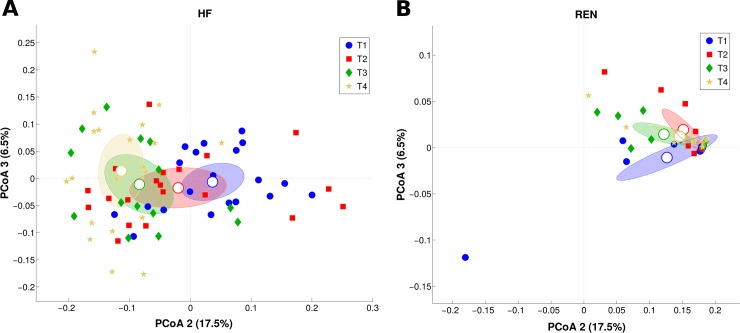
PCoA of weighted UniFrac distances representing the differences in milk microbiota structure along time points.Each dot represents a single quarter milk sample, while the centroid represents its average value. Percent variance accounted for by the second and third principal component is shown along the axis. (A) PCoA plots for HF; P-values are statistically significant (p < 0.02) for all pairwise comparison, except T2 vs. T3. (B) PCoA plots for REN; P-values are not statistically significant (p > 0.05).